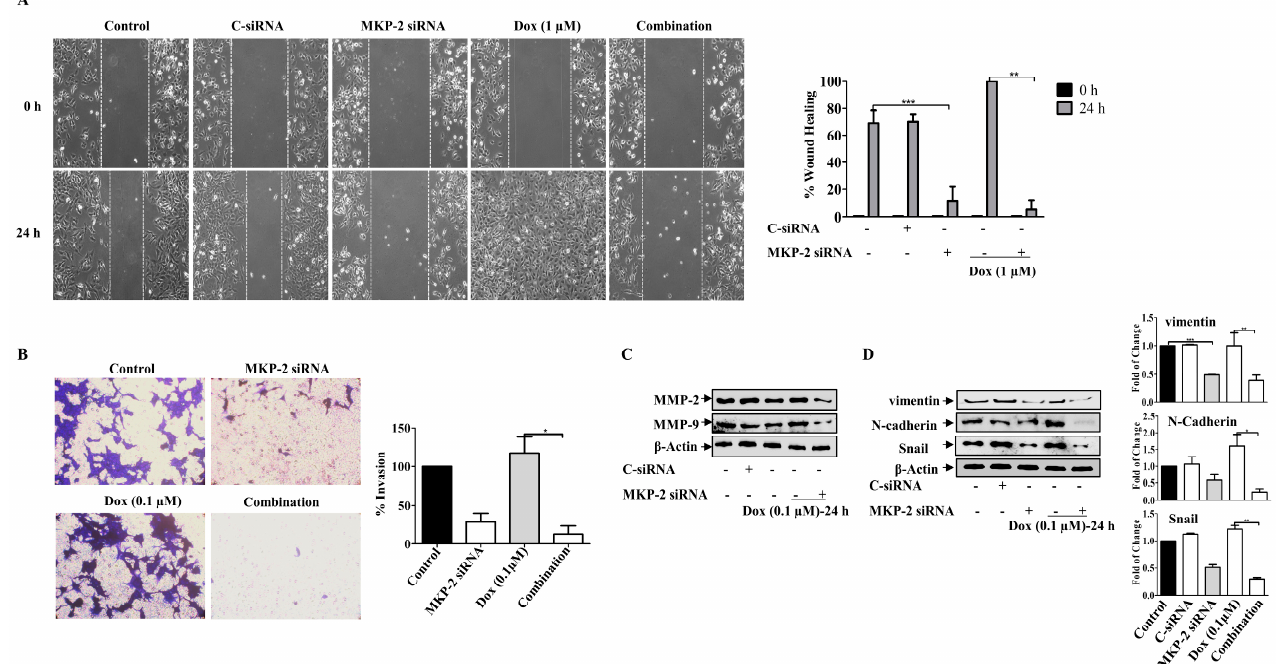
Figure 6. MKP~2 Promotes Dox Resistance Through EMT. MDA-MB-231 cells were transfected with MKP-2 siRNA for 72 h, then treated with the indicated Dox concentrations for another 24 h. ( A ) The wounded area was photographed (10×) and % of wound closure was evaluated and the result expressed as a percentage based on the ratio of the treated cells to the controls. ( B ) A cell invasion assay was performed, and the invaded cells were photographed. Cell lysates were prepared, separated by SDS-PAGE, and then assessed for ( C ) MMP-2 and MMP-9 ( D ) N-cadherin, vimentin, Snail and β -Actin. Each value represents the mean ± S.E.M of three independent experiments. * p ≤ 0.05, ** p ≤ 0.01, *** p ≤ 0.001, compared with the correspondent control.